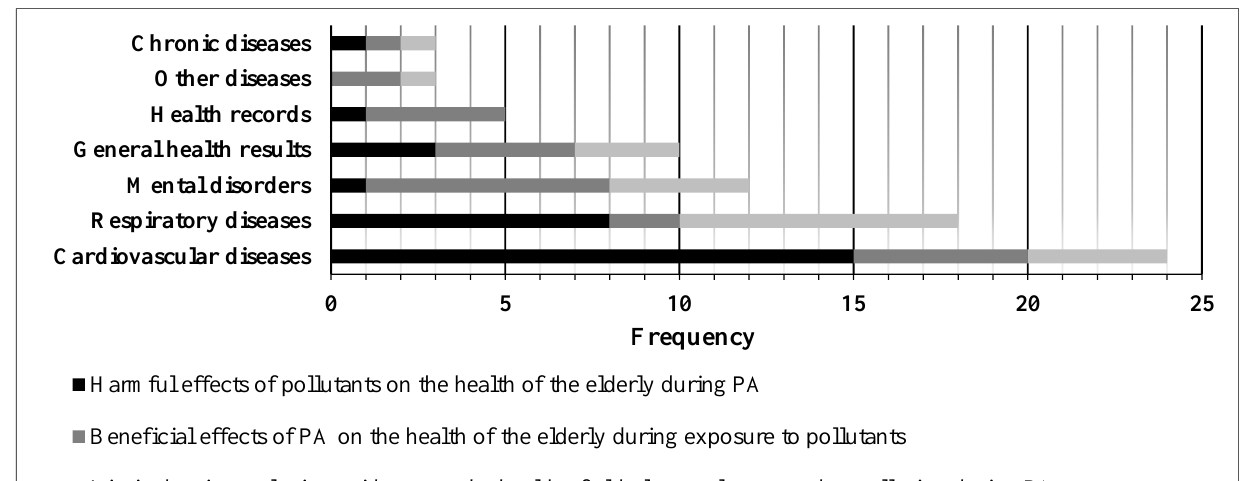
Figure 4. Number of studies according to the health outcomes investigated during physical activity in older adults and the effects of air pollution.